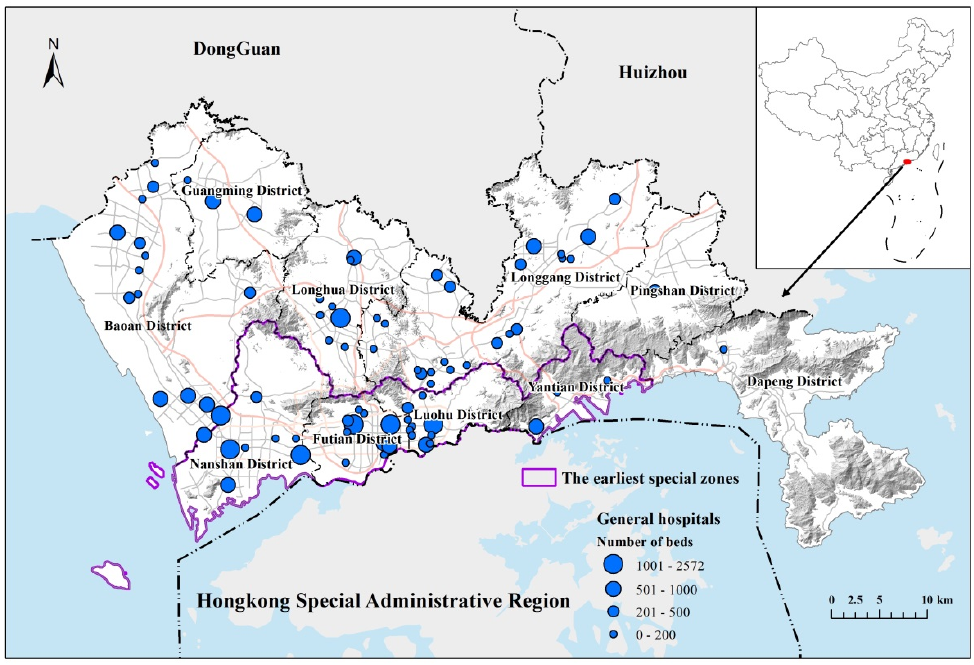
Figure 1. Location of Shenzhen and the distribution of general hospitals. Data source: hospitals, Health Commission of Shenzhen; basic geographic information, Shenzhen Municipal Bureau of planning and natural resources.